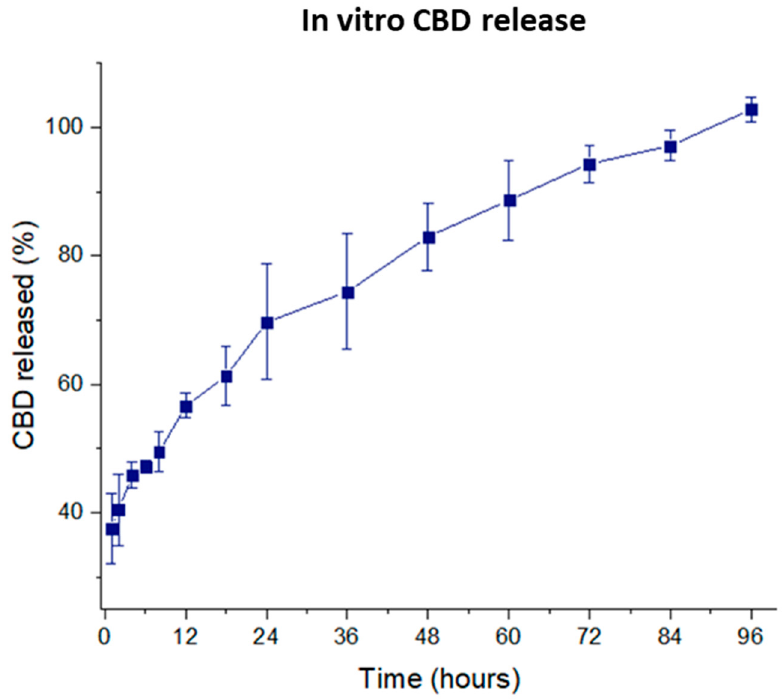
Figure 2. CBD release profile ( n = 4).